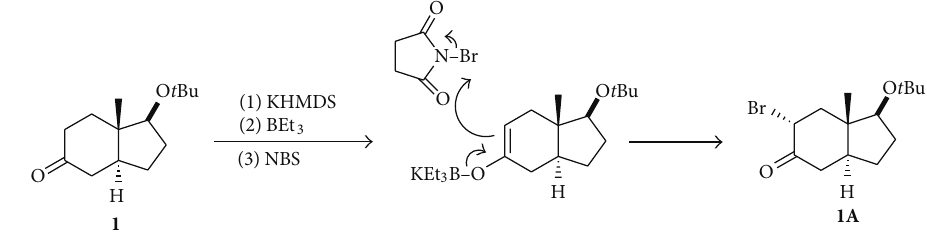
Scheme 2: Proposed mechanism of bromination